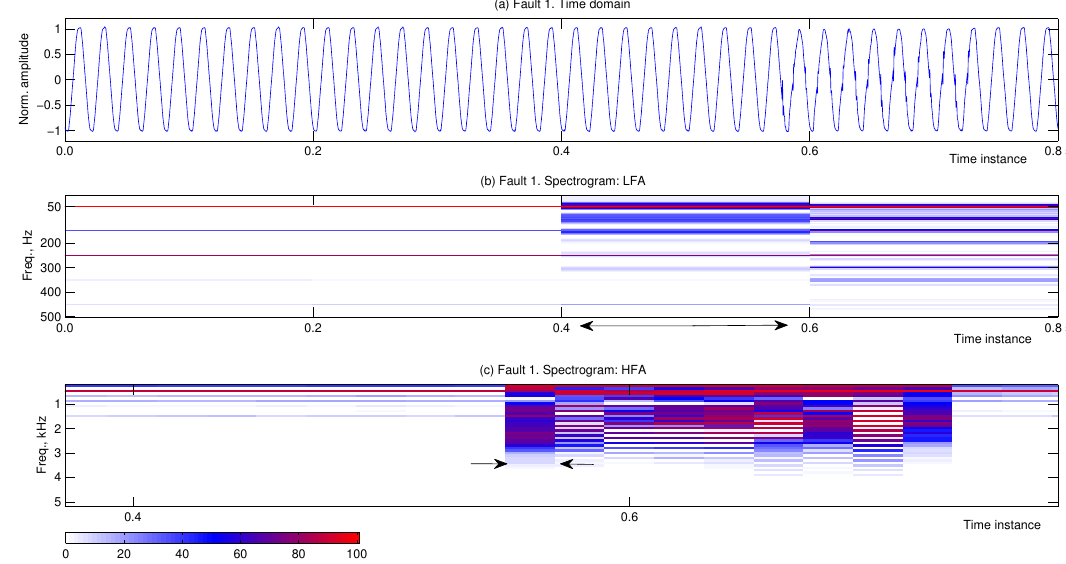
Figure 3. Fault #1: Harmonics. From top to bottom: the time domain signal, the LFA (a segment embraces 0.2 s), and the HFA (a segment is equivalent 0.02 s). The scale in the lower-left corner indicates the value of the PQ index. The arrows mark the segments limits.